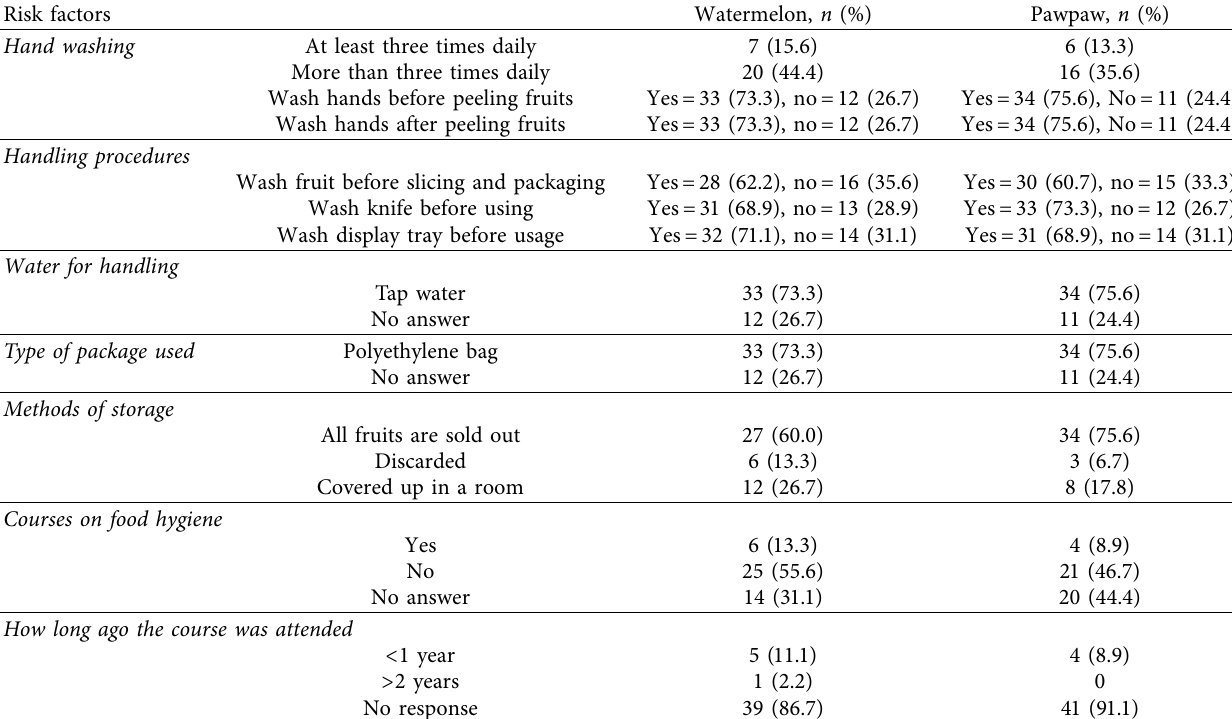
Table 2: Fruit vendors of packaged pawpaw and watermelon and associated risk factors.